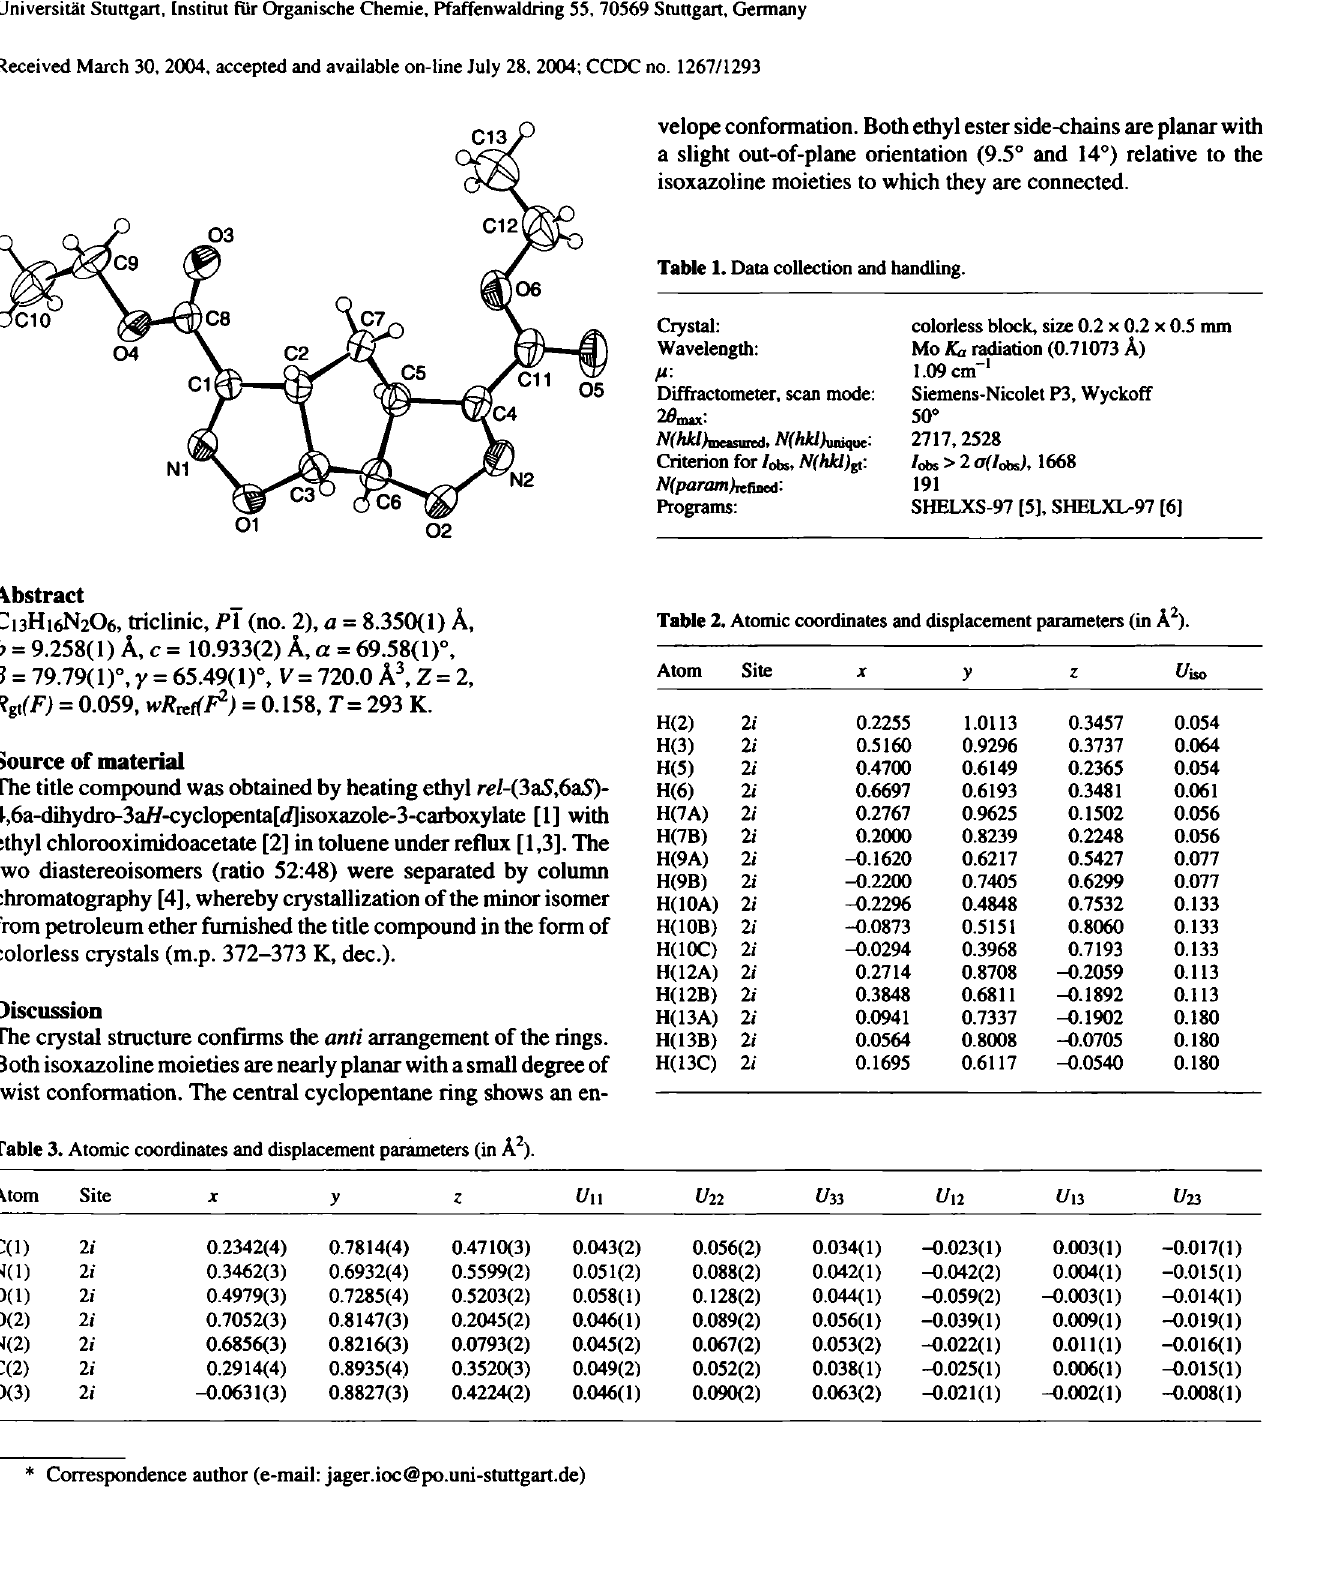
Table 2. Atomic coordinates and displacement parameters (in Â 2